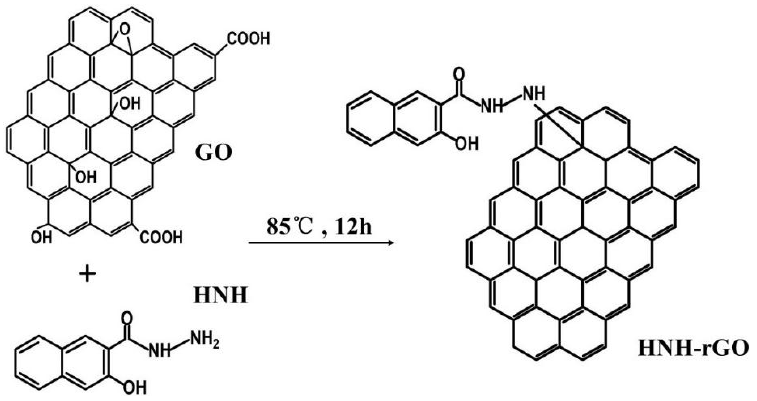
Figure 2. Synthesis reaction of HNH modified reduced graphene oxide (HNH-rGO) from graphene oxide (GO).